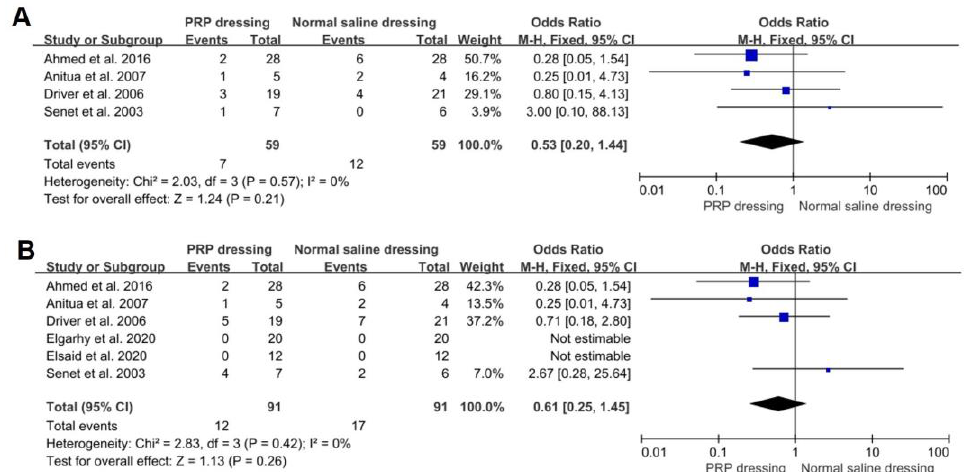
Figure 4. Forest plot showing the rate of complications of PRP dressing versus normal saline dressing. ( A ) Infection rate during treatment. The events were the number of infected wounds after treatment. ( B ) Adverse events rate during treatment. The events were the number of adverse events after treatment.